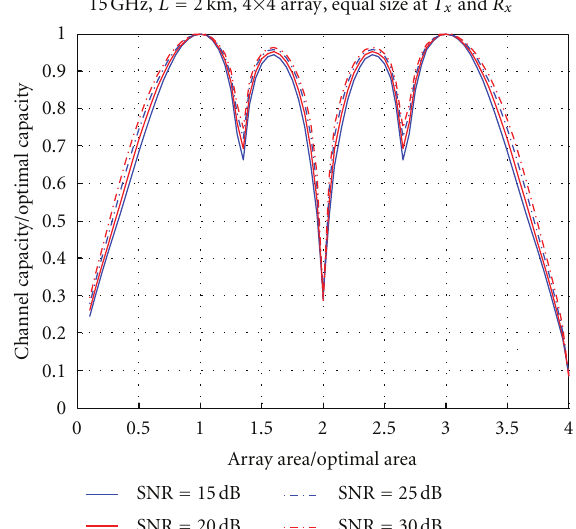
Figure 3: Channel condition number versus antenna array area.